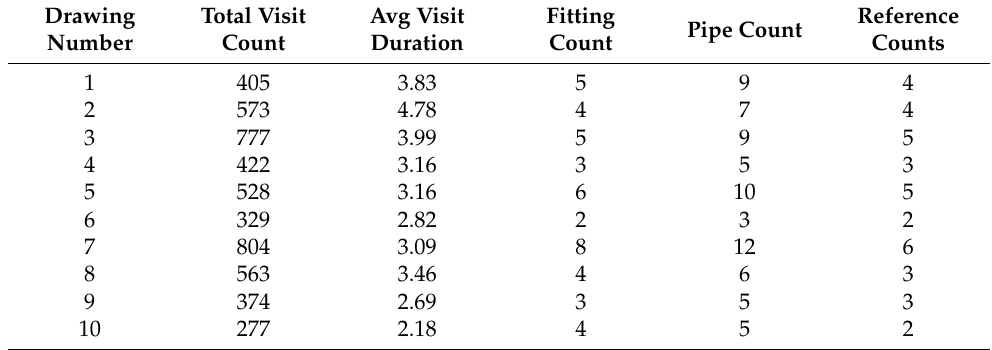
Table A2. Assembly drawing data